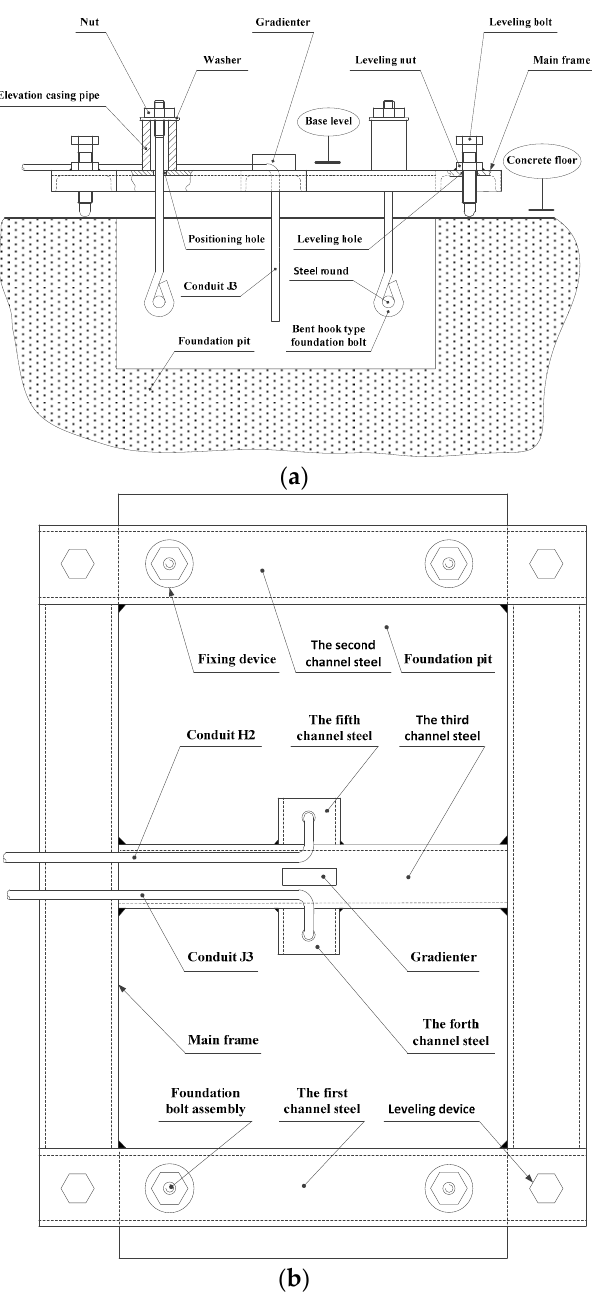
Figure 9. Machine tool foundation construction subsystem. ( a ) Front view; ( b ) top view.